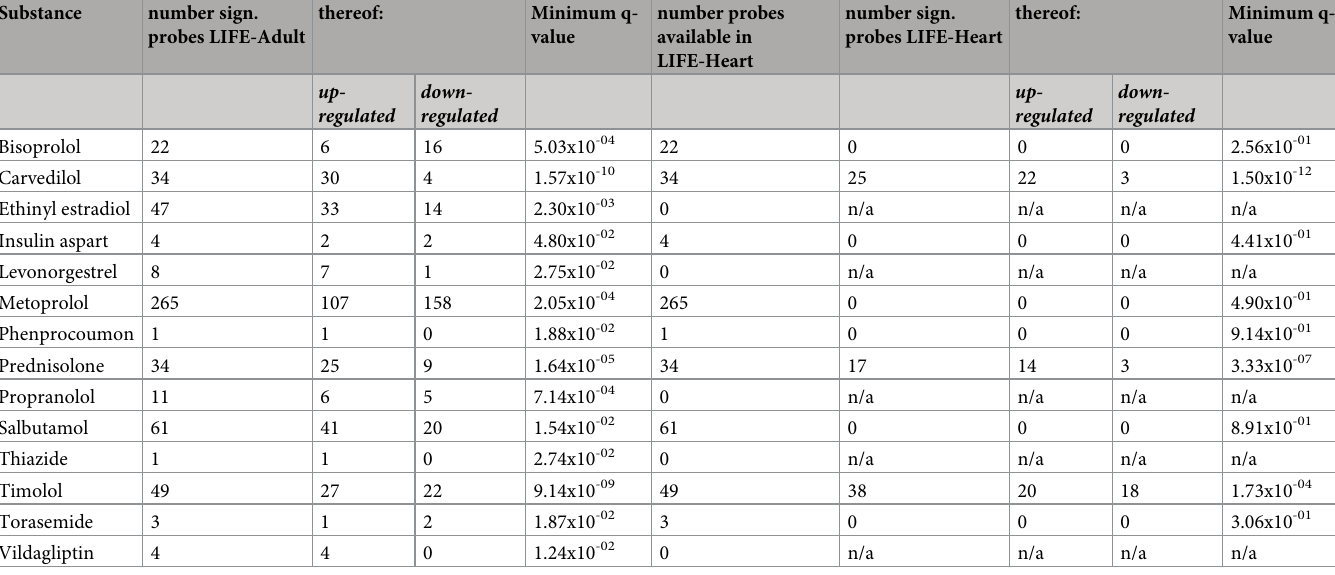
Table 3. Substances that cause differential gene expression in LIFE-Adult and their replication in LIFE-Heart. Substance number sign. probes LIFE-Adult